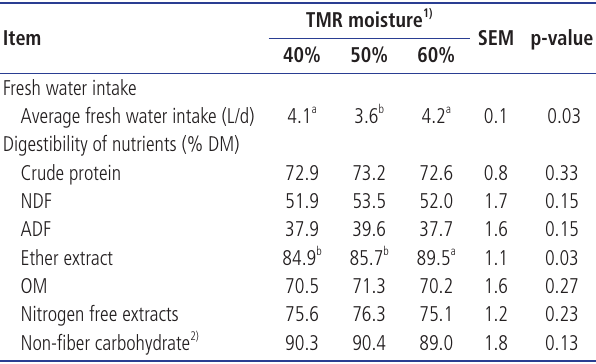
daily fresh water intake between the 40% and 60% TMR moisture groups (Table 4).